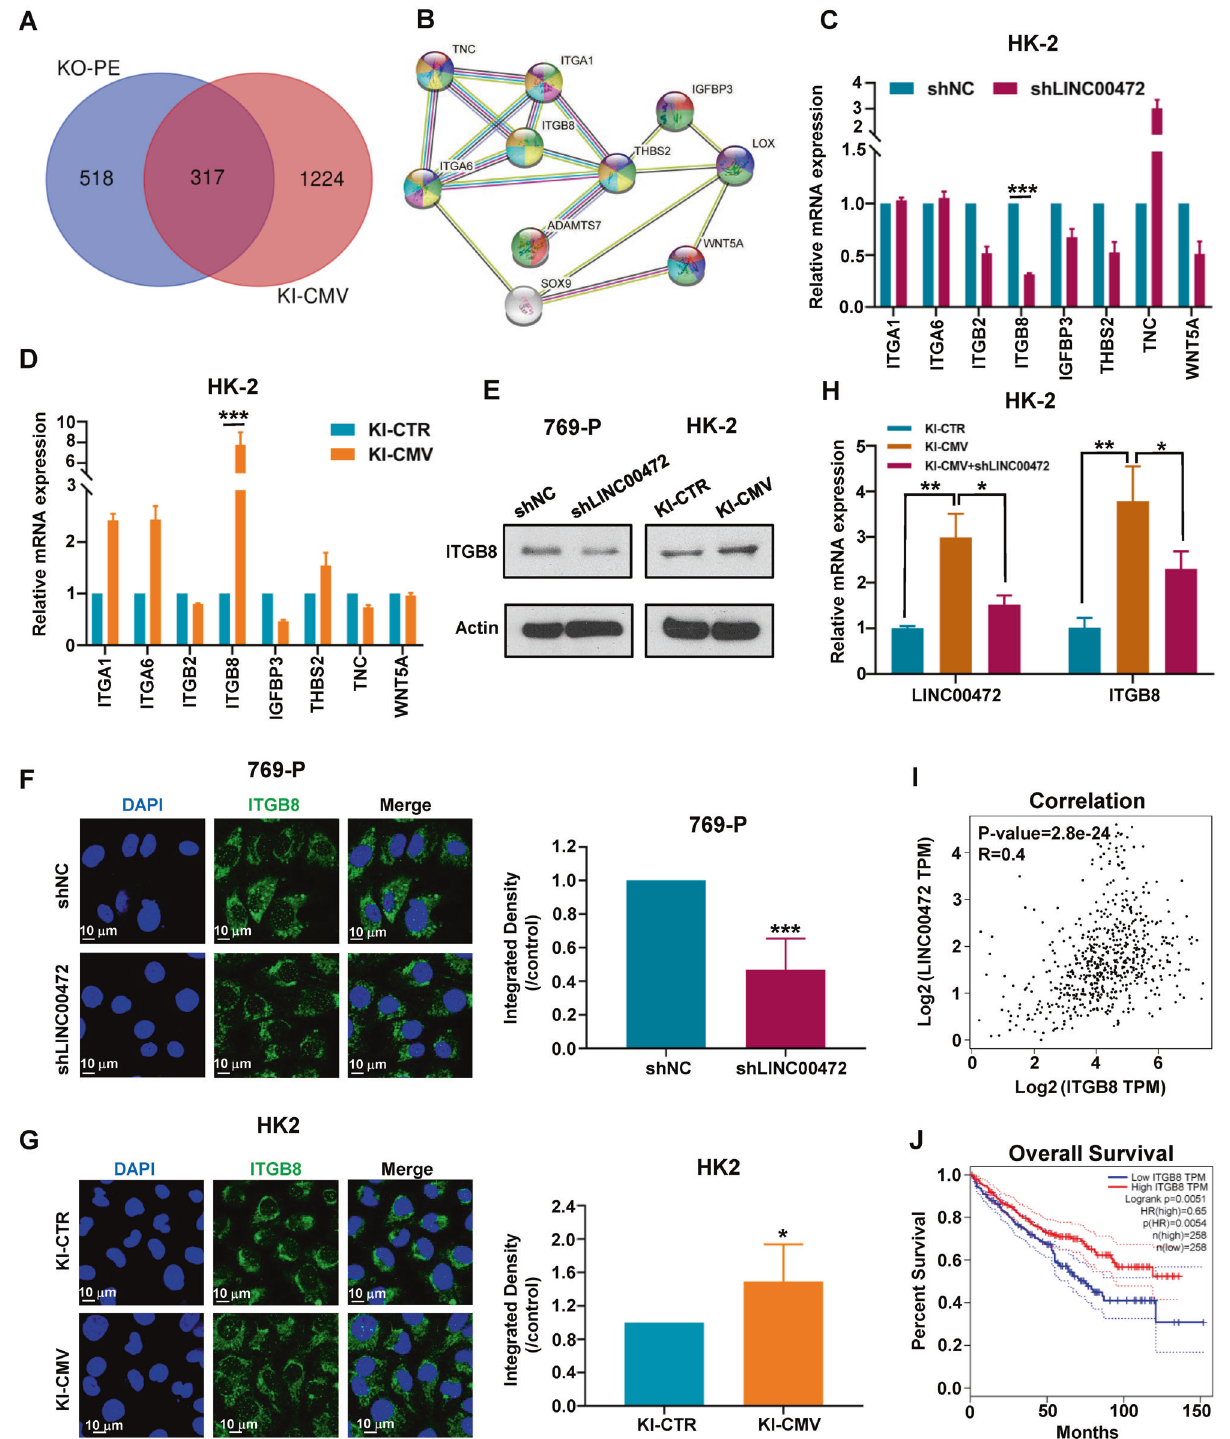
Fig. 7 ITGB8 is a potential target gene regulated by LINC00472. A Analysis of RNA-seq overlap difference genes of HK-2 KO-NC/KO-PE and HK-2 KI-NC/KI-CMV. B The central sub network of the network which got by using PPI interaction analysis of differential genes produced by RNA-Seq in STRING database. RT-qPCR was used to detect the mRNA level of these network node molecules in HK-2 shNC and shLINC00472 cell line ( C ), and HK-2 KI-CTR and HK-2 KI-CMV cell line ( D ). E Western blot was used to detect the ITGB8 protein level in HK-2 and 769-P cells. The expression and distribution of ITGB8 in 769-P cell ( F ) and HK-2 cell ( G ) were detected by immuno fl uorescence (Left). Statistics of integrated density (Right). H RT-qPCR was used to detect the mRNA level of LINC00472 and ITGB8. I The correlation between LINC00472 and ITGB8. J Relationship between the expression of ITGB8 and the prognosis of RCCC patients. In C , D , F – H , data were shown as mean ± SD of three independent experiments (* P < 0.05, ** P < 0.01, *** P < 0.001).